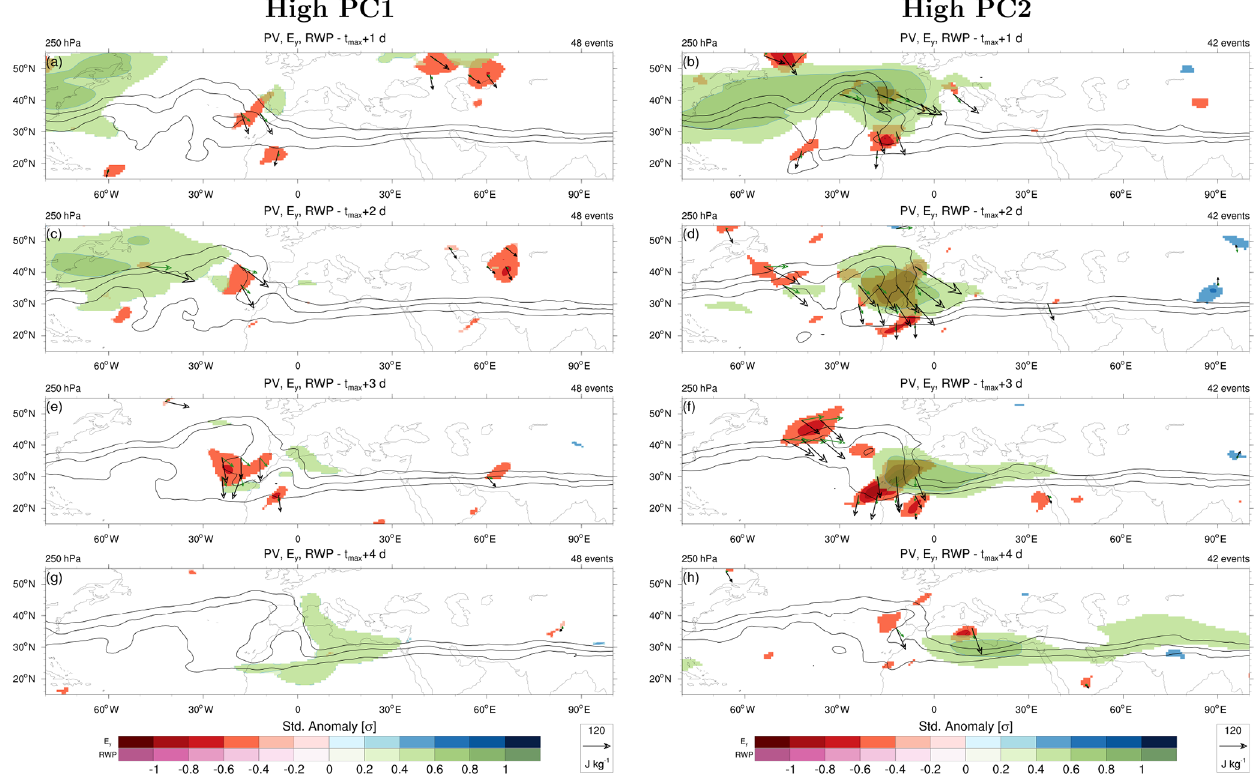
Figure 10. Lagged composites of significant ( p < 0 . 01) 250hPa standardized anomalies in E y (red for anticyclonic tilt, blue for cyclonic tilt of transient eddies) and logarithm of RWP amplitude (green for positive, magenta for negative values) for (left) CRWP1 and (right) CRWP2 events at (a, b) + 1d, (c, d) + 2d, (e, f) + 3d and (g, h) + 4d with respect to t max . The composite of PV at 250hPa is overlaid (black contours; only 1, 1.5 and 2PVU), as well as the composite E vectors (black arrows) and DJF mean E vectors (green arrows) emanating from areas of significant E y